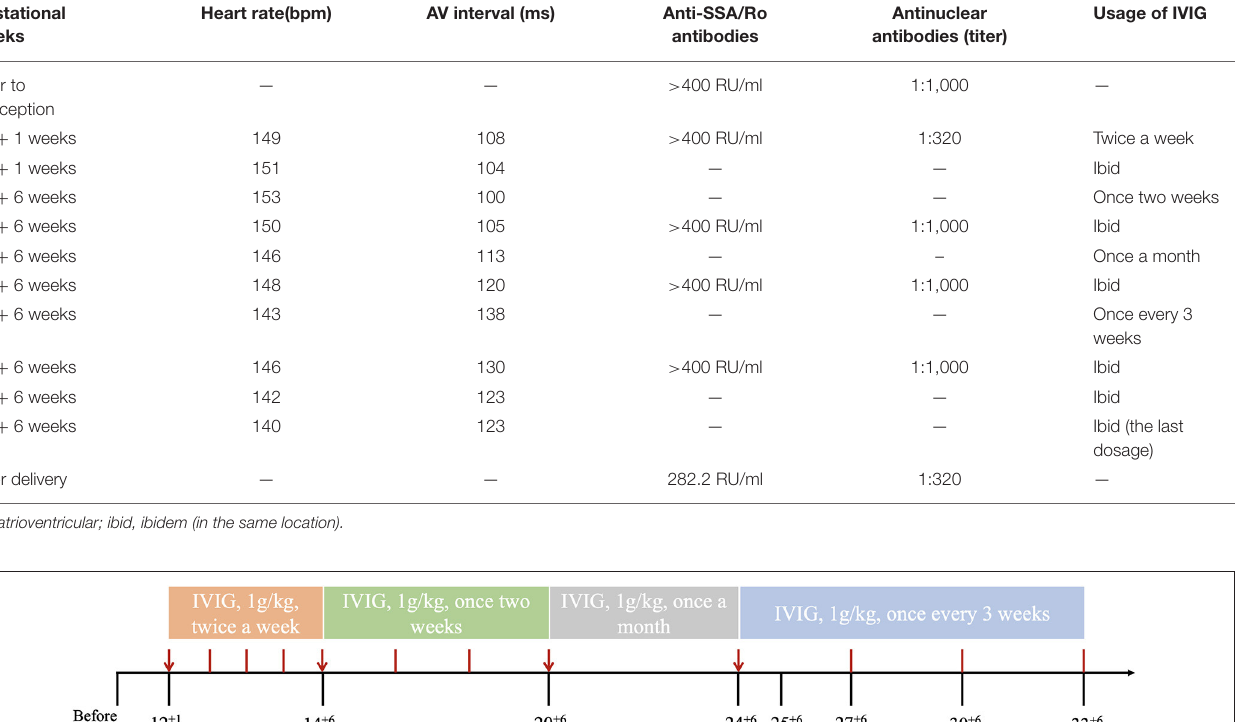
Antinuclear Usage of IVIG antibodies antibodies (titer)